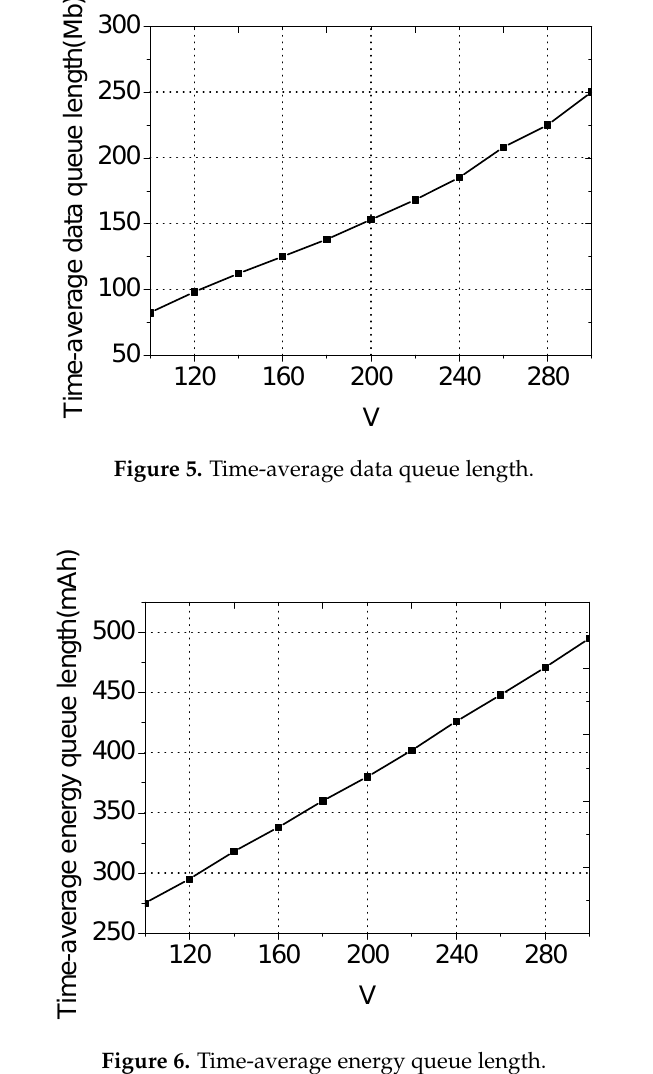
Figure 6. Time-average energy queue